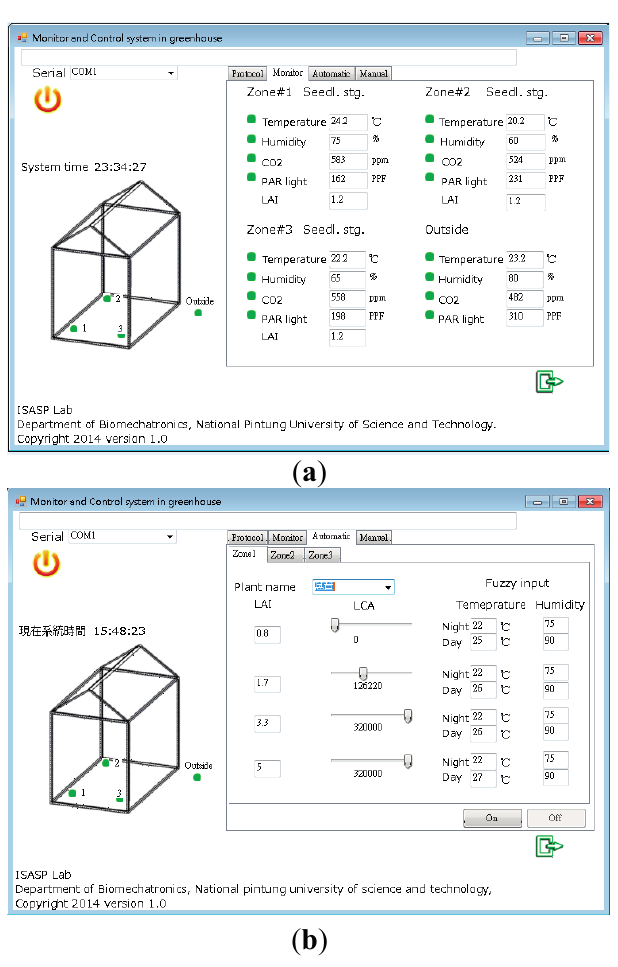
Figure 6. Monitoring of environmental parameters of various zones. ( a ) Monitoring of environmental parameters of various zones; ( b ) parameters setting under automatic control